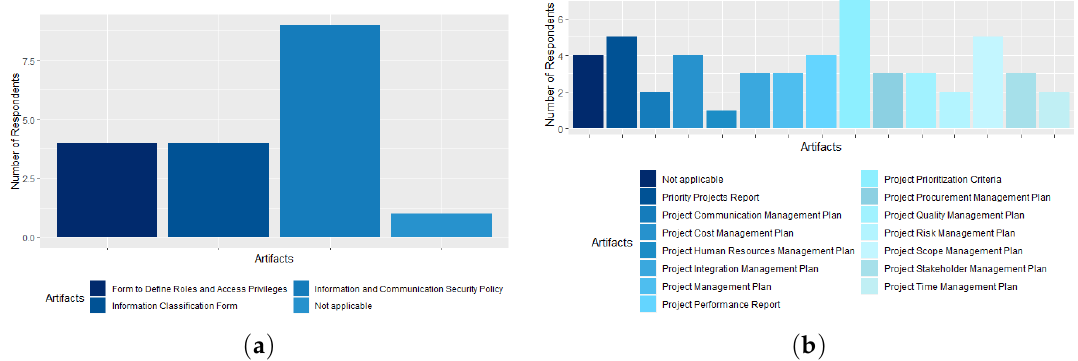
Figure 18. ( a ) The Information and Communication Security Policy process artifacts; ( b ) the ICT Project Management process artifacts.